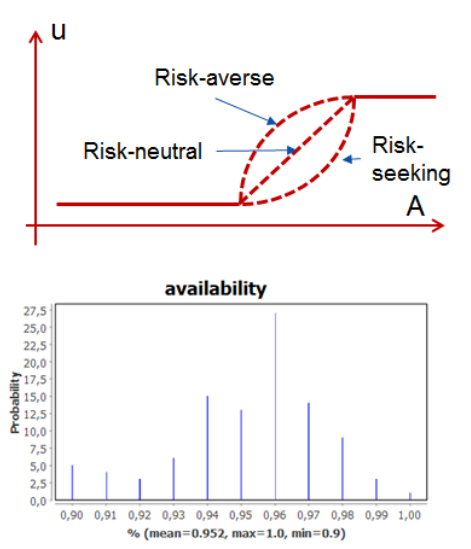
Figure 12. An illustration of how utility (sketch above) is derived from availability (histogram below) depending on the minUtilityAvailability and maxUtilityAvailability